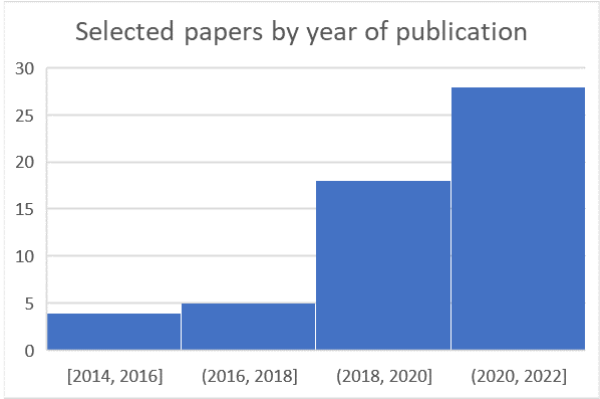
Figure 5. Selected papers by year of publication.